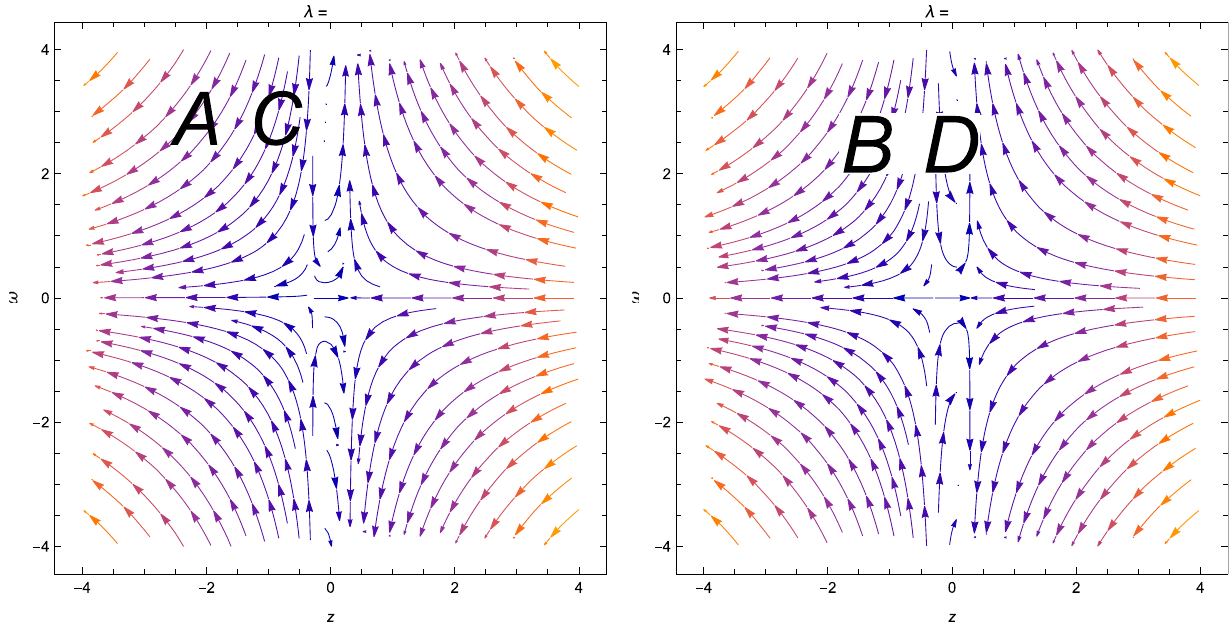
Fig. 2 Phase portrait for mixed power law model. Here we plot the graph between y and w and z and w